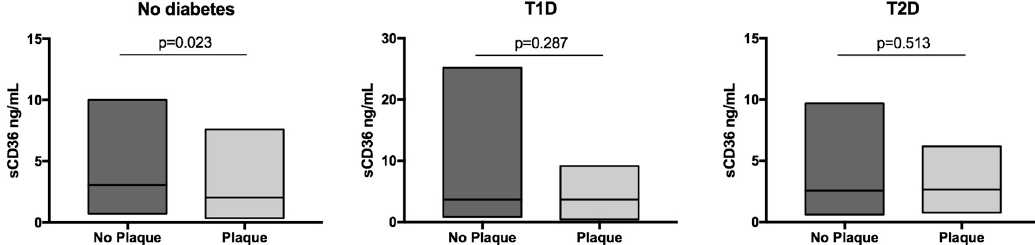
Figure 1. Concentrations of sCD36 according to the presence of atherosclerotic plaque by group. Soluble CD36 in quartiles was Ln transformed.